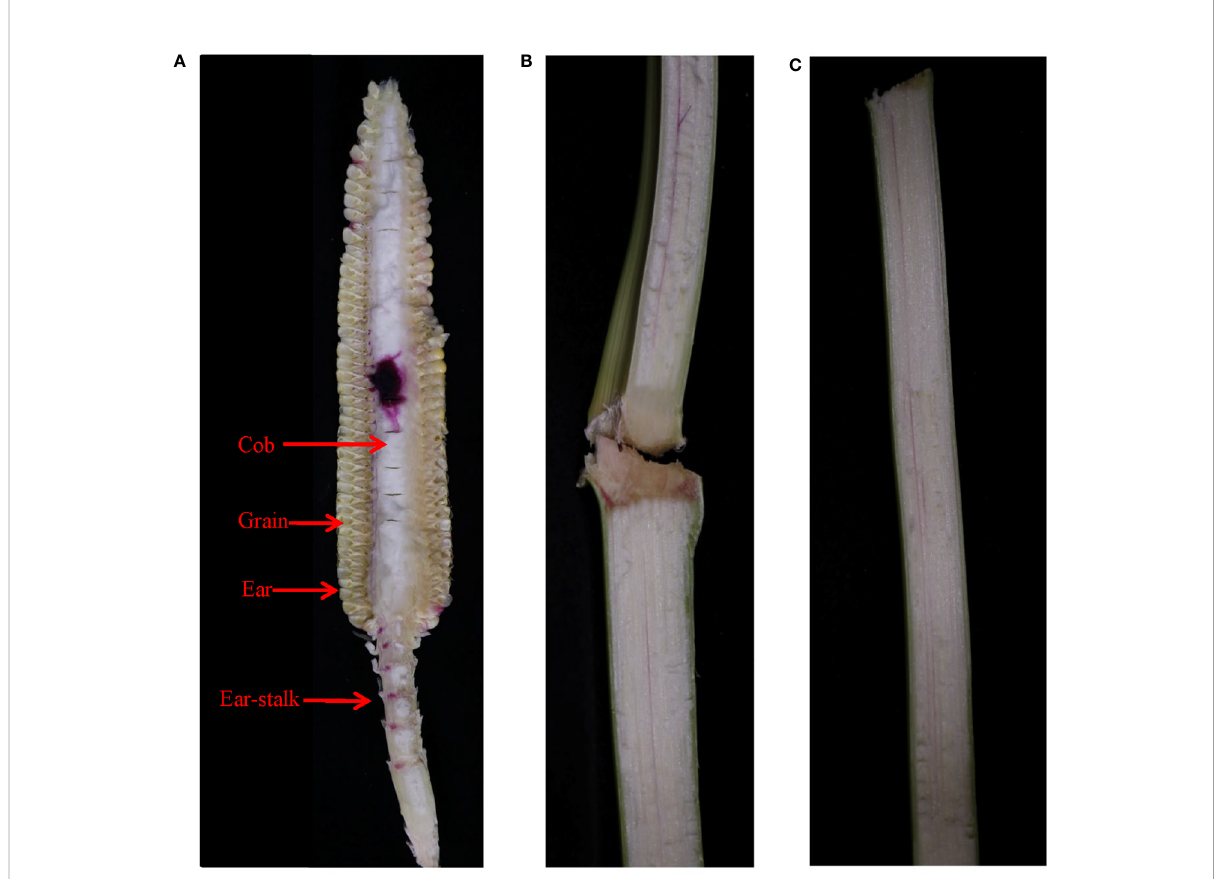
FIGURE 7 The movement of the xylem-mobile dye (basic fuchsin) infused through the cob of JNK728 through (A) the ear-stalk to (B) the stems bearing ear 1 day after the infusion, and further up (C) the stem 3 days after the